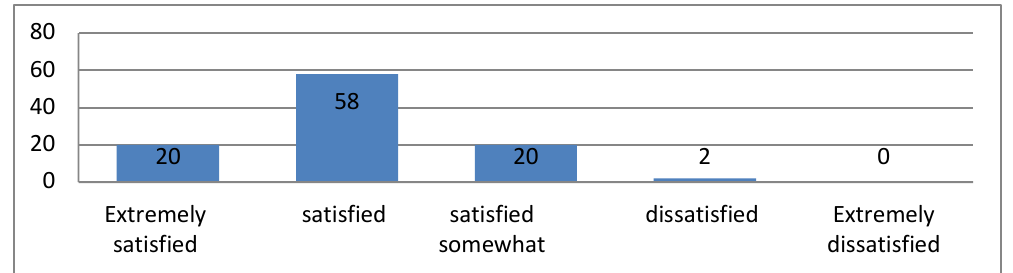
Figure 14 : You have opportunities’ for engagement in training and education activities that are beyond that needed in your job.